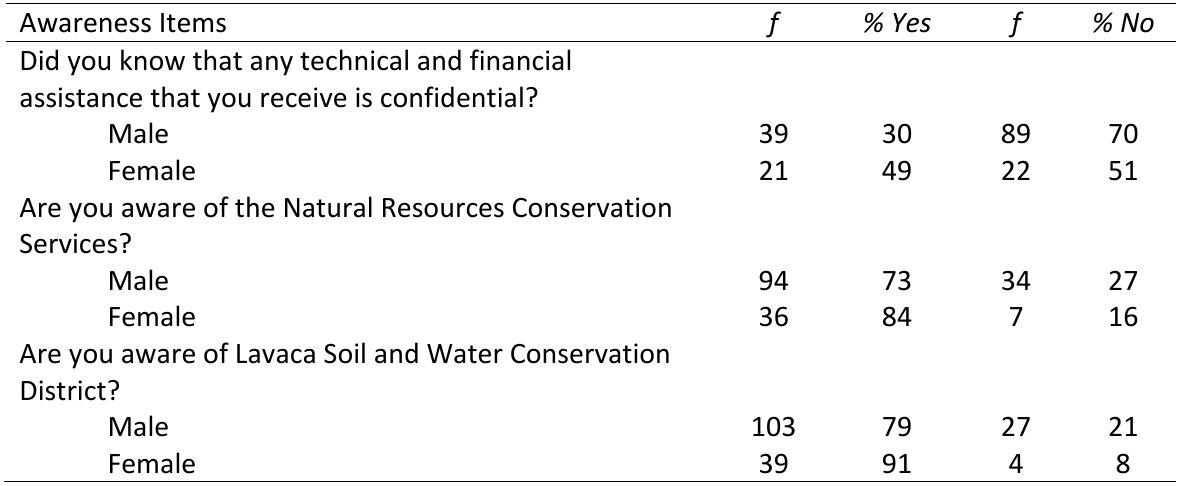
Descriptive Statistics of Gender on Awareness of Natural Resources Conservation Service & Texas State Soil and Water Conservation